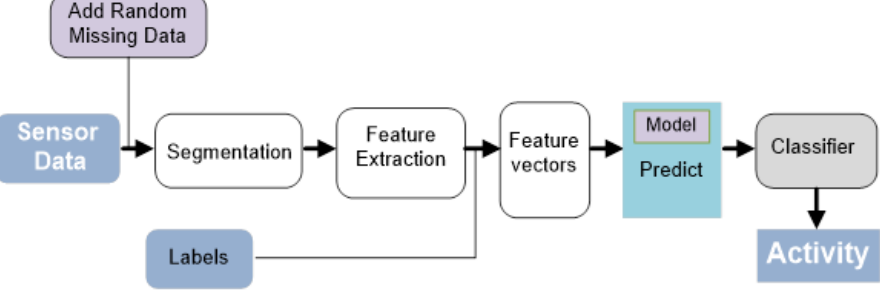
Figure 1. Illustration of activity recognition work flow considering missing data